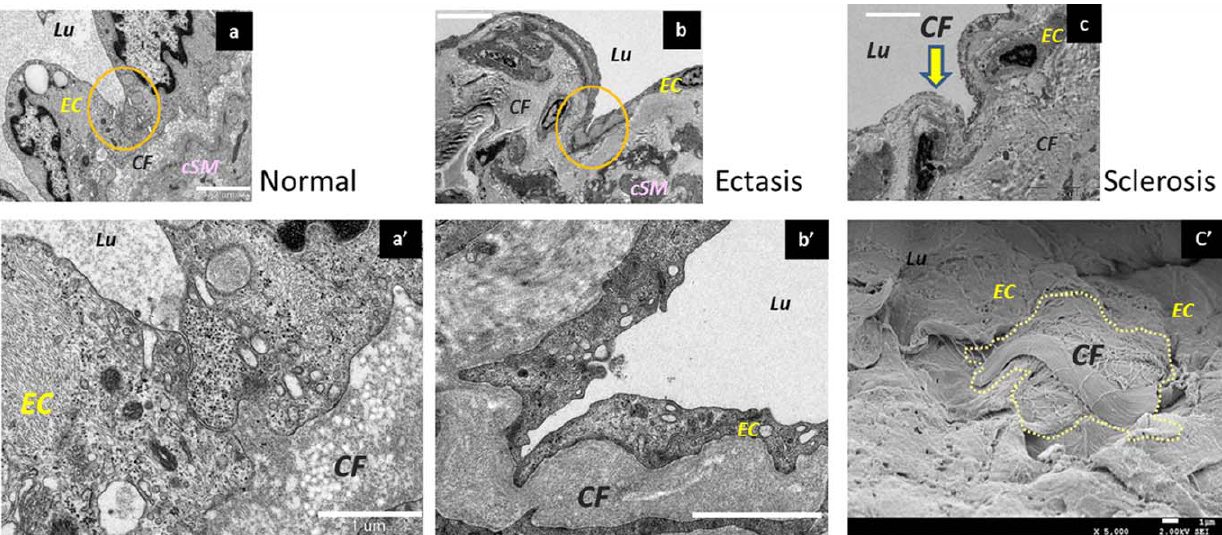
Figure 5. Changes in the desmosomes of lymphatic vessel endothelial cells as shown by electron microscopy. (a) Desmosomes in the normal type. In a three-dimensional structure, they adhere to the adjacent lymphatic vessel endothelial cells. Bar=2 m m. (a’) Magnified image. Bar=2 m m. (b) Desmosomes of lymphatic vessel endothelial cells in the ectasis type. The cell-to-cell adhesions have gradually loosened and disassembled, so that the cells adhere only at points. Bar=10 m m. (b’) Magnified image. Bar=2 m m. (c) Lymphatic endothelial cells in the collecting lymphatic vessels in the sclerosis type. The desmosomes are disassembled, and the collagen fibers under the lymphatic vessel endothelium are exposed in the lymphatic vessel lumen (yellow arrow). Bar=5 m m. (c’) Collagen fibers exposed in the lymphatic vessel lumen (Electron microscopy, SEM). Lymphatic vessel endothelial cells are missing, and fascicles of collagen fibers are exposed in the lymphatic vessel lumen. Bar=1 m m. EC; endothelium cells, sSM; synthetic smooth muscle cells, cSM; contractile smooth muscle cells, CF; collagen